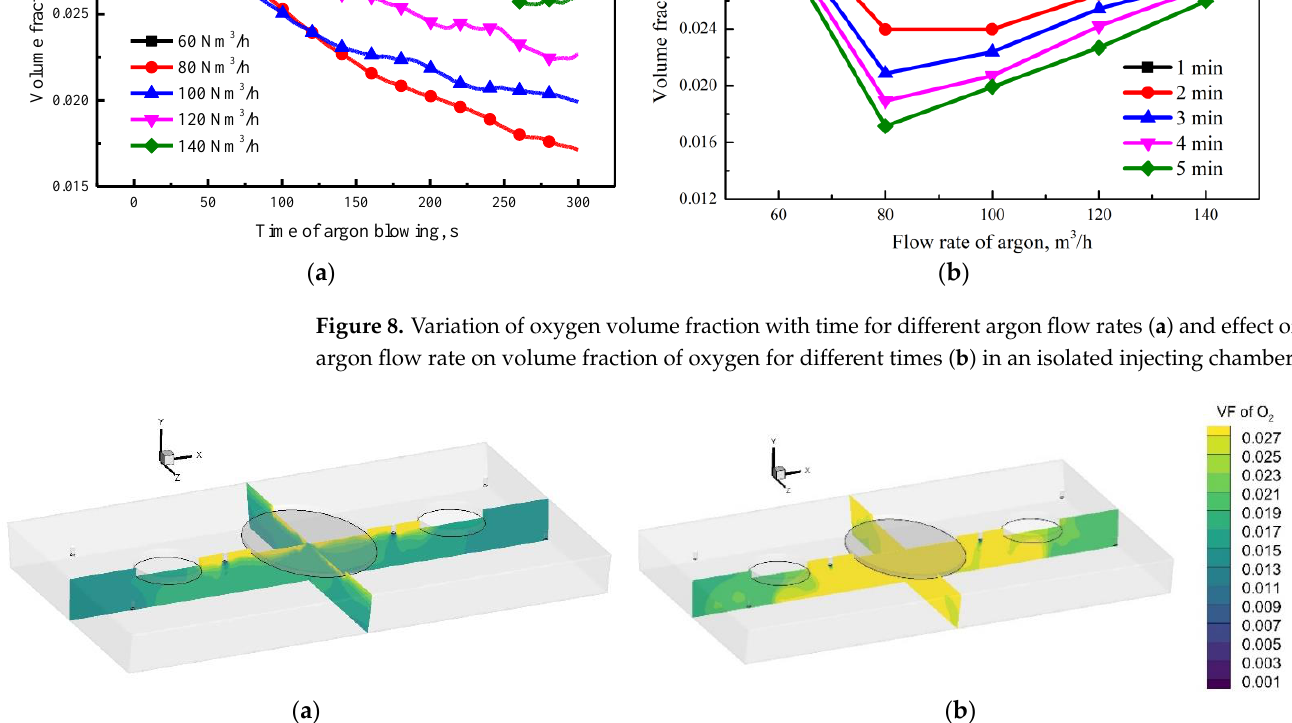
Figure 9. Contour of argon volume fraction at the z = 0 m section for different argon flow rates in the injecting chamber: ( a ) 80 Nm 3 /h, and ( b ) 140 Nm 3 /h.